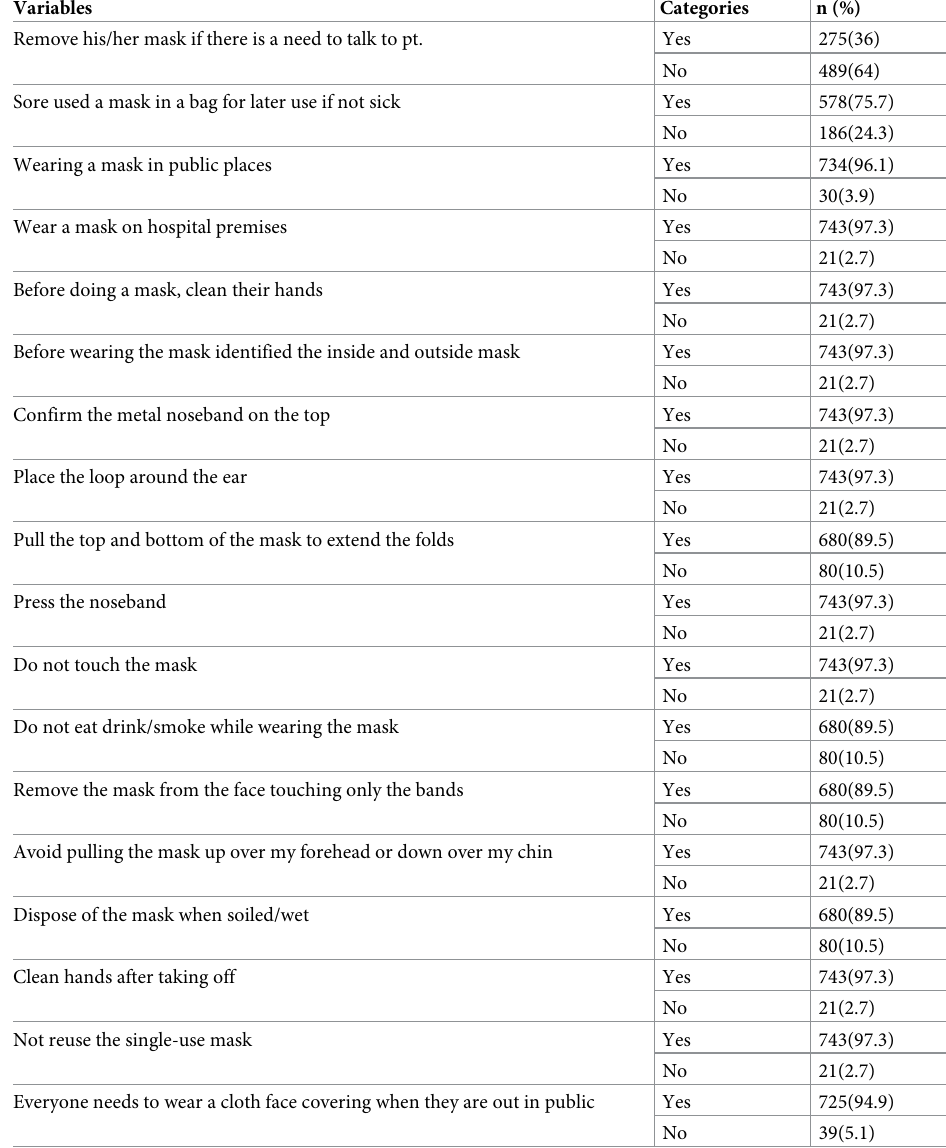
Table 4. Practices-related questioner on knowledge, attitudes, and practices of face mask utilization and associ- ated factors in COVID-19 pandemic among Wachemo university students, southern Ethiopia: February to March 2021 (n =